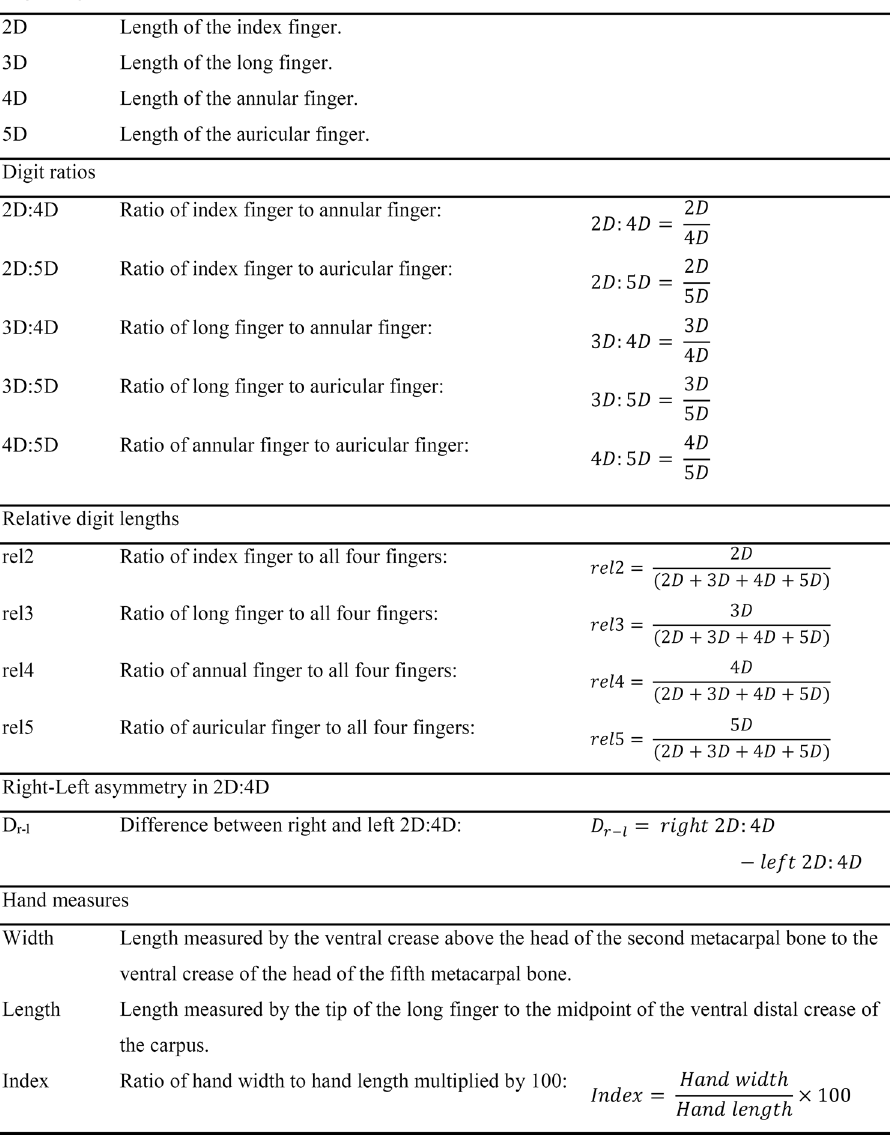
Table 1. Overview of calculated digit and hand